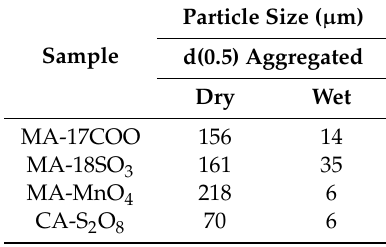
Table 7. d(0.5) 1 values ( µ m) of the median particle size of the wet and dried aggregated reactive samples [8,14].